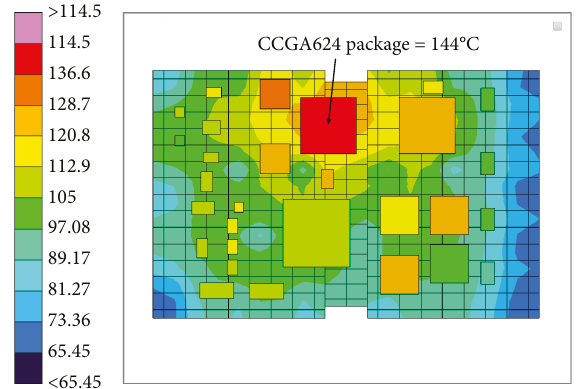
Figure 4: Temperature contour maps of CCGA624 packages with 0% compression ratio of the thermal gap pad.